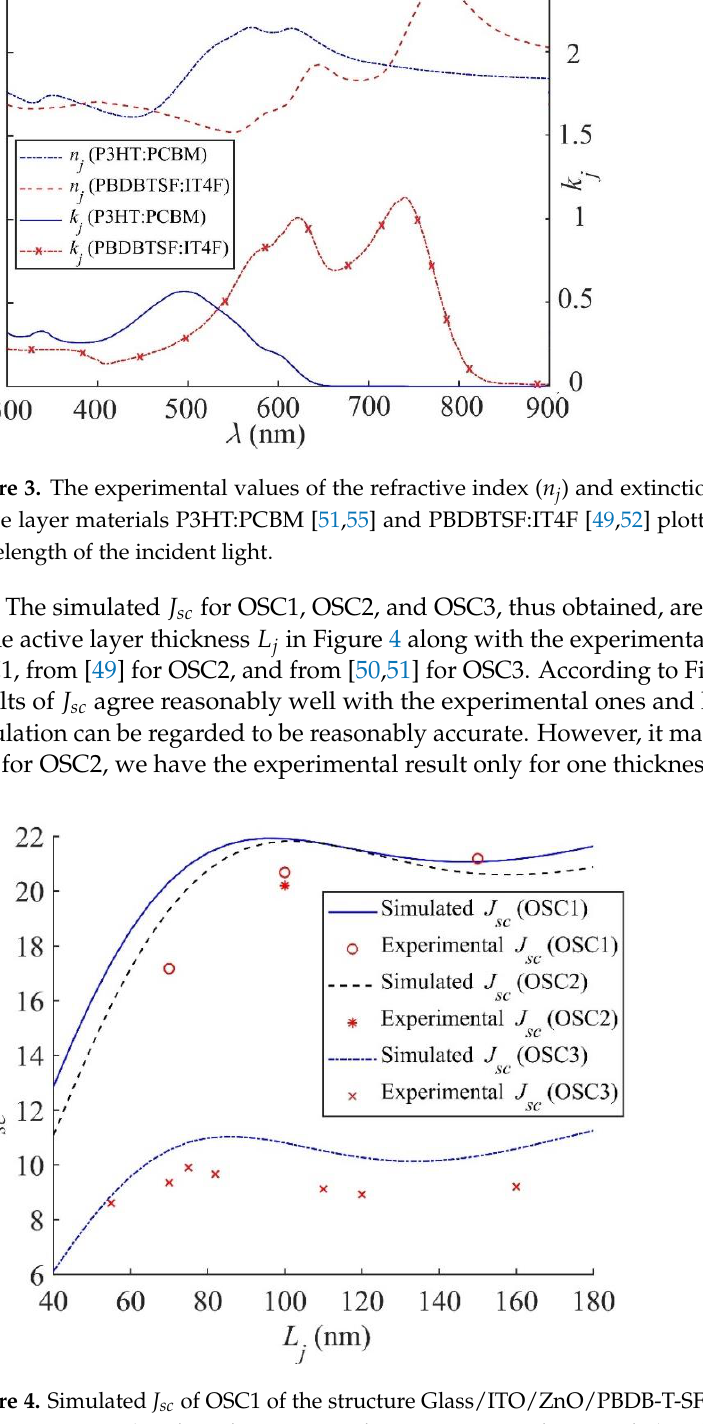
Table 1. Input parameters required in the simulation.